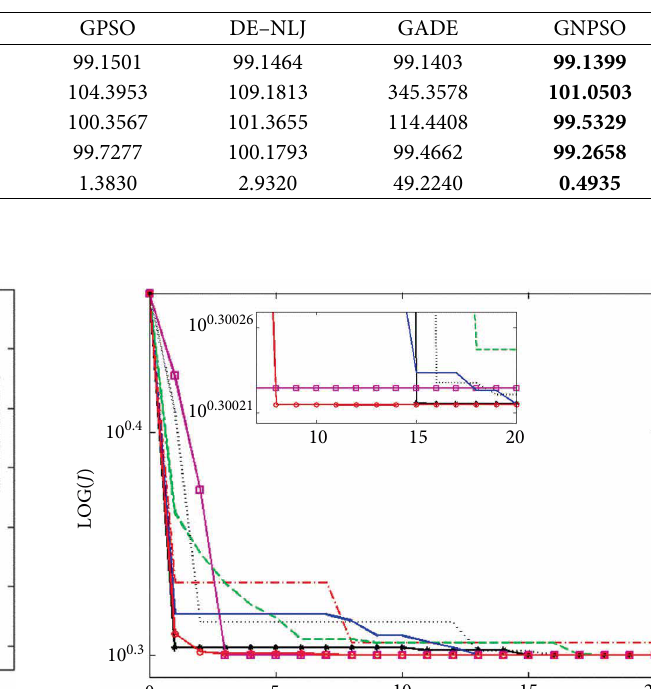
Table 7: Statistical results of the control performance using different algorithm for nonlinear wing vibration system.